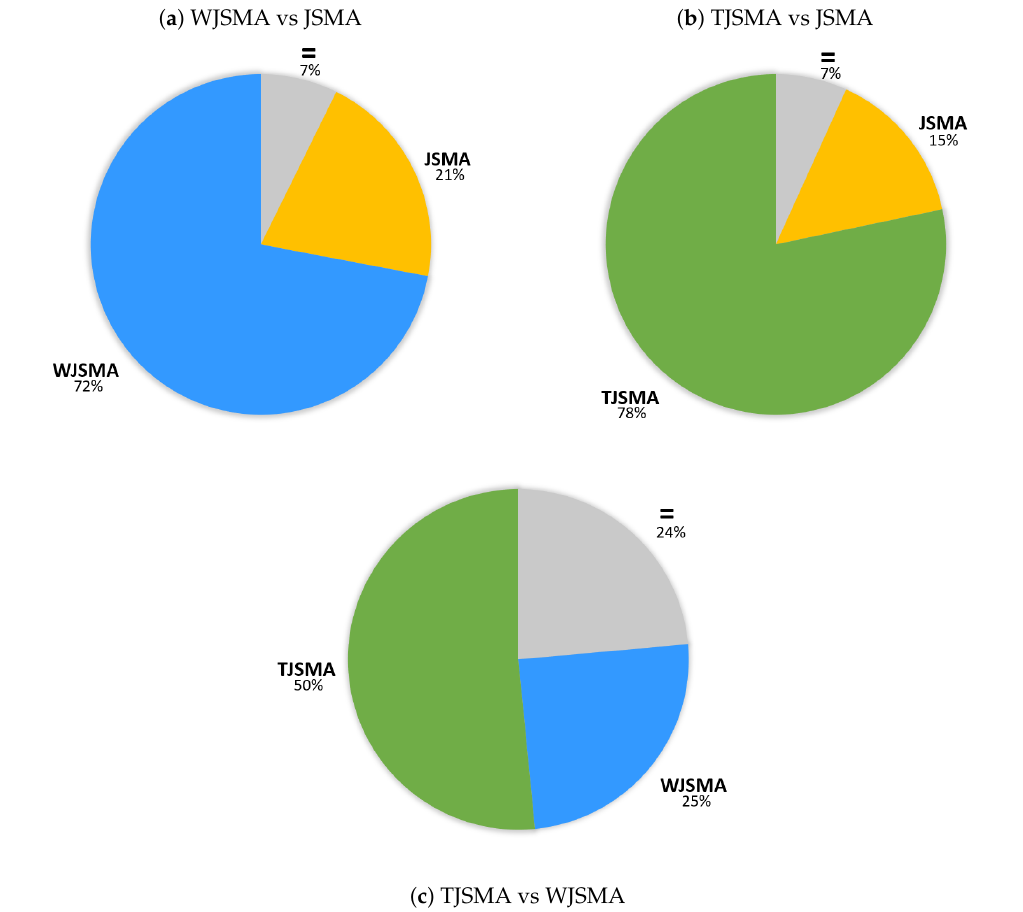
Figure A1. Pairwise dominance on MNIST comparing WJSMA with JSMA ( a ), TJSMA with JSMA ( b ) and TJSMA with WJSMA ( c ). On these charts, “=” corresponds to samples with the same number of iterations by the attacks including when both attacks